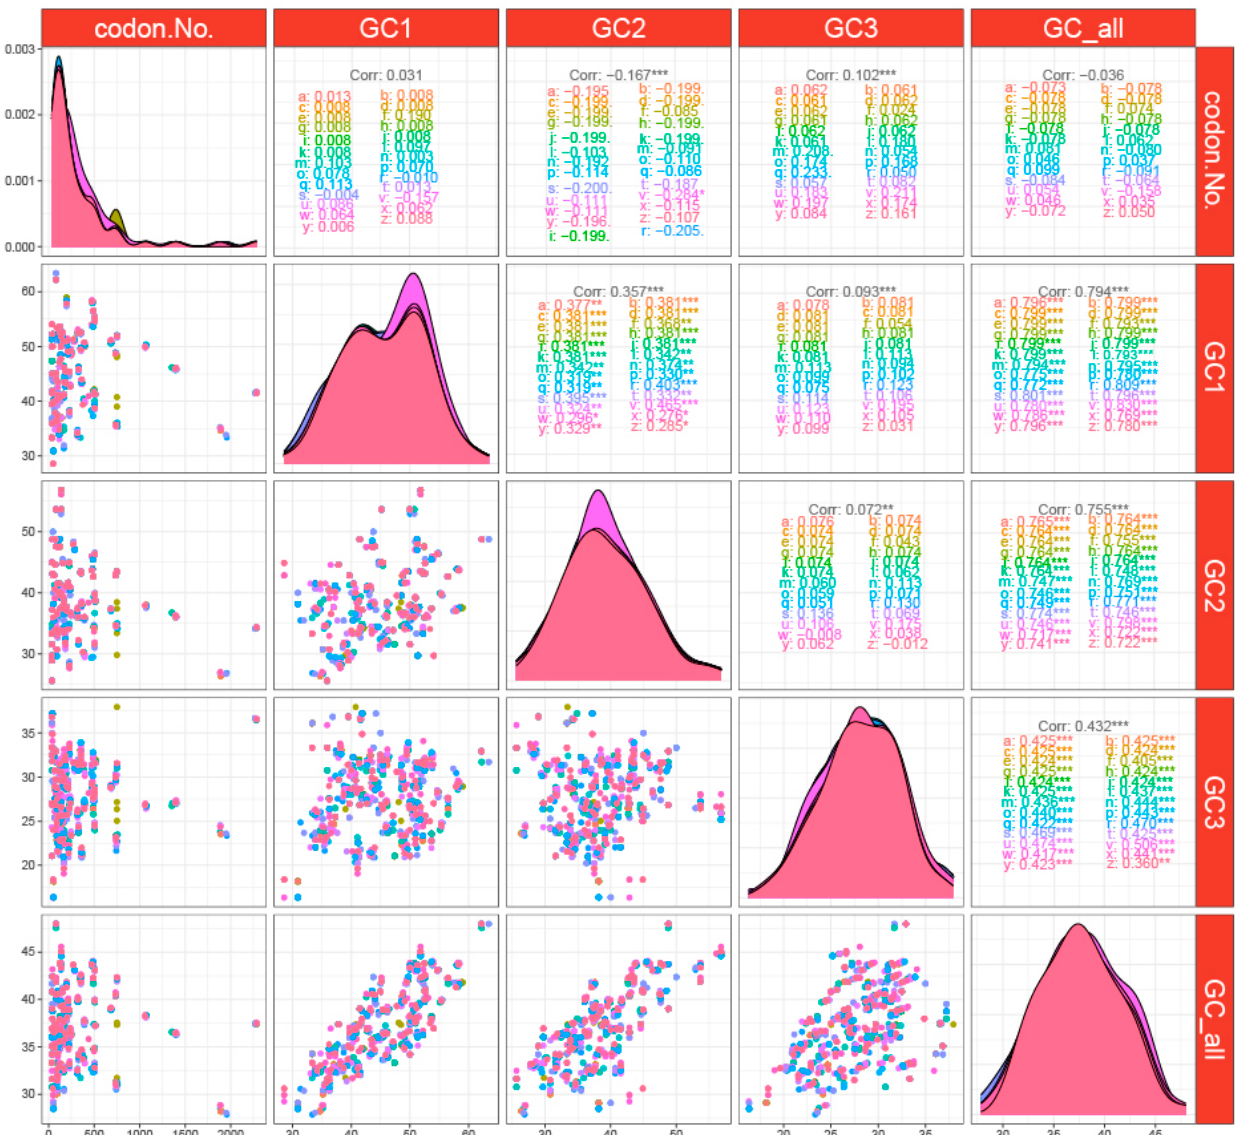
Figure 1. The explanation for correlation analysis of GC content at different locations in the figure. * indicates that the correlation has reached a significant level ( p < 0.1). ** indicates that the correlation has reached a significant level ( p < 0.05); *** indicates that the correlation has reached a very significant level ( p < 0.01). The different colored letters in the upper right correspond to the different colored peaks in the middle and the different colored points in the lower left. Lowercase letters from a to z indicate “ J. regia (a), J. regia 192 (b), J. regia 193 (c), J. regia 194 (d), J. regia 196 (e), J. regia 197 (f), J. regia 198 (g), J. regia 199 (h), J. regia 200 (i), J. regia 201 (j), J. regia 202 (k), J. mandshurica (l), J. hopeiensis (m), P. stenoptera (n), P. macroptera (o), P. hupehensis (p), P. tonkinensis (q), E. hainanensis (r), E. roxburghiana (s), A. sinensis (t), C. paliurus (u), C. kweichowensis (v), C. hunanensis (w), C. illinoensis (x), C. cathayensis (y), and C. tonkinensis (z),”